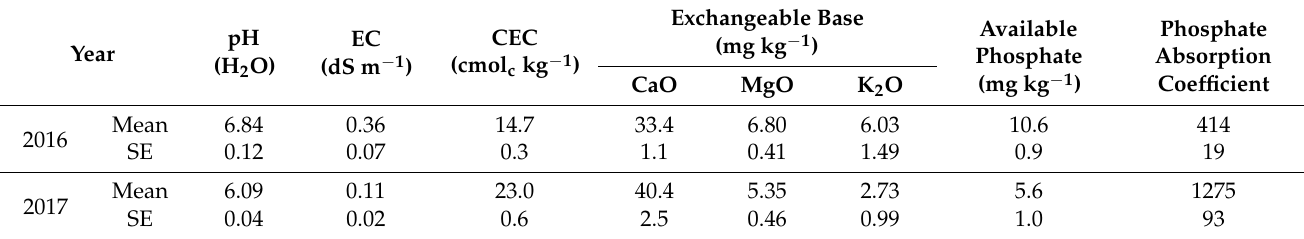
Table 1. If the electrical conductivity (EC) is 0.5 dS m − 1 or less, by convention, it can be considered that there is no residual nitrogen in the soil in this district. Table 1. Soil properties of test